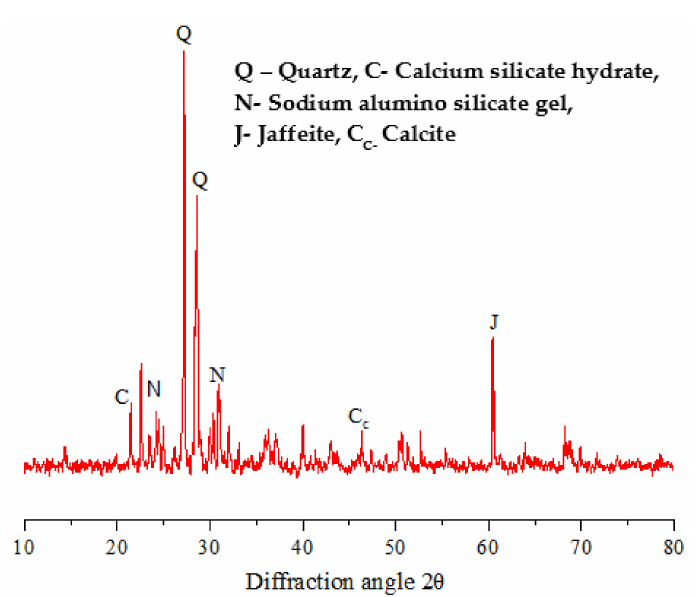
Figure 17. XRD for steel slag.